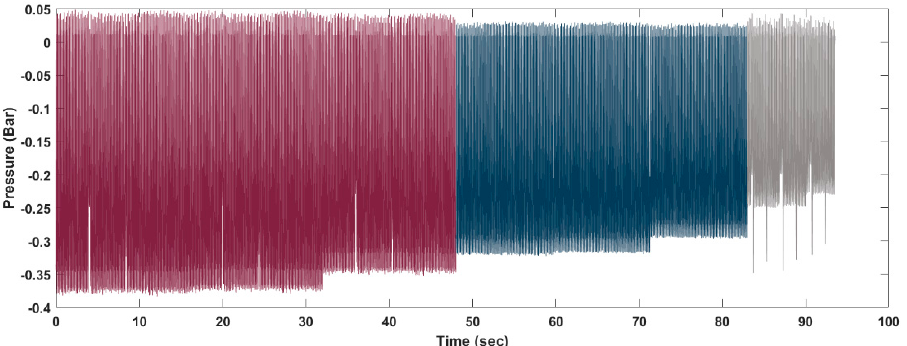
Figure 11. Degradation dataset.